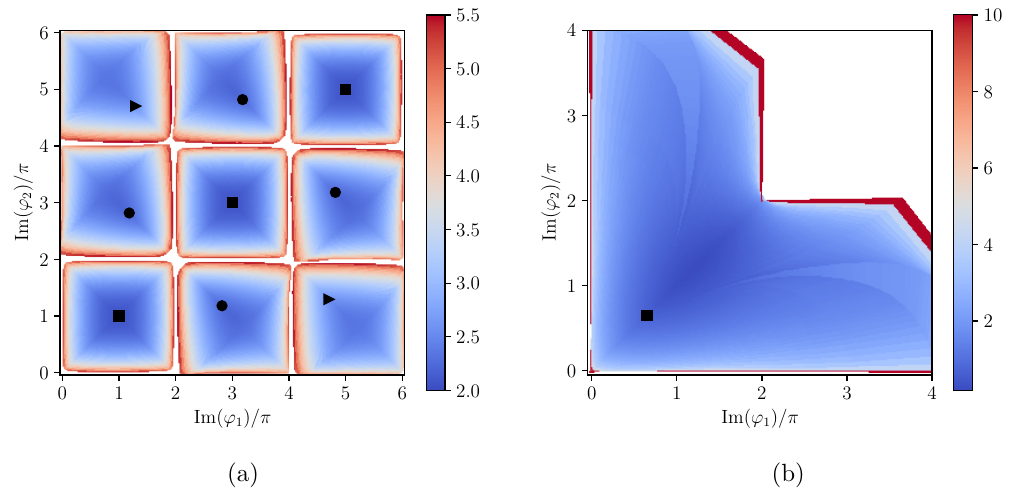
Figure 6 . (a) Lefschetz thimbles of the two site action, with η = 8 , and b 2 = − 1 , projected to the plane of (Im( ϕ ) , Im( ϕ )) . The solid markers indicate projection of the saddle points; the ones 1 2 with the same type of marker are related by a shift of the zero mode ϕ . The color code indicate 0 max Re( ϕ ) . We observe that the thimbles are similar to the elementary cycles in that, the i =1 , 2 i imaginary parts of the field are confined in boxes ϕ [2 πh 2 π ( h + 1)] , h Z . (b) A Lefschetz i ∈ i , i i ∈ thimble with η = 1 and b 2 = e − i θ , θ = 0 . 65 π , with the same color code above. It is no longer confined in a square box of side 2 π . This indicates that a Stokes phenomenon has taken place in the interval θ ∈ (0 . 65 π, π )